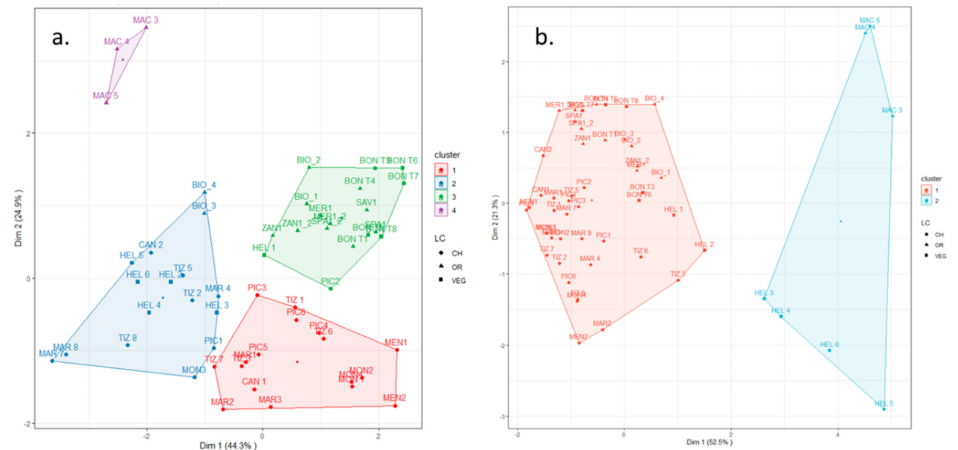
Figure 3. K-means clustering on the topsoil ( a ) and subsoil ( b ) layers based on the variables organic carbon, bulk density, soil respiration rate, microbial biomass, total nitrogen, and pH, depicted here on a PCA plot. CH, OR, and VEG refer to the main type of land use (CH—chestnut; OR—orchards; and VEG—other uses, such as grassland and the cultivation of vegetables and raspberries, as detailed in Table A1). Table 1. Means ± standard errors of the minimum set of indicators of each cluster at 0–15 and 15–30 cm depths, with